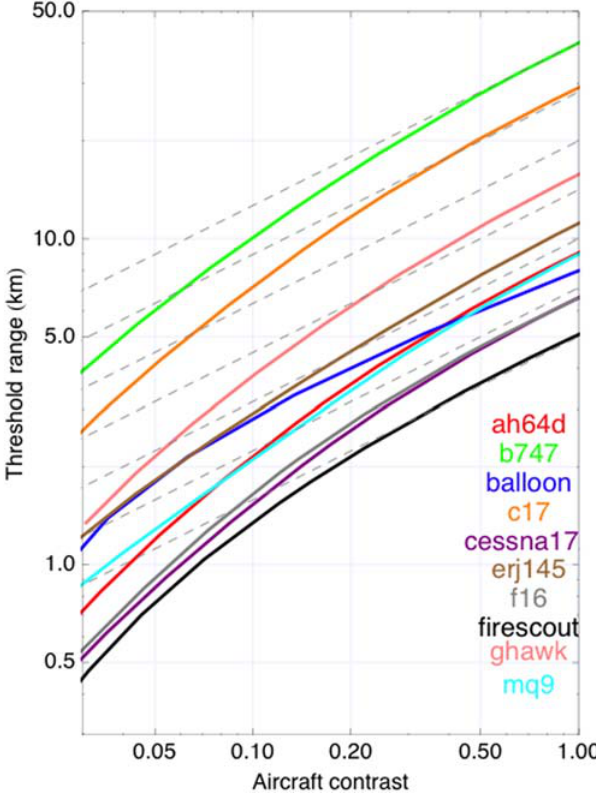
Figure 15. Contrast sensitivity functions derived from SSO parameters optimized for each observer. The black curve is the original SSO CSF. For two of the observers, the curves lie above and to the right of the original curve, indicating that they have greater sensitivity and acuity than the SSO.